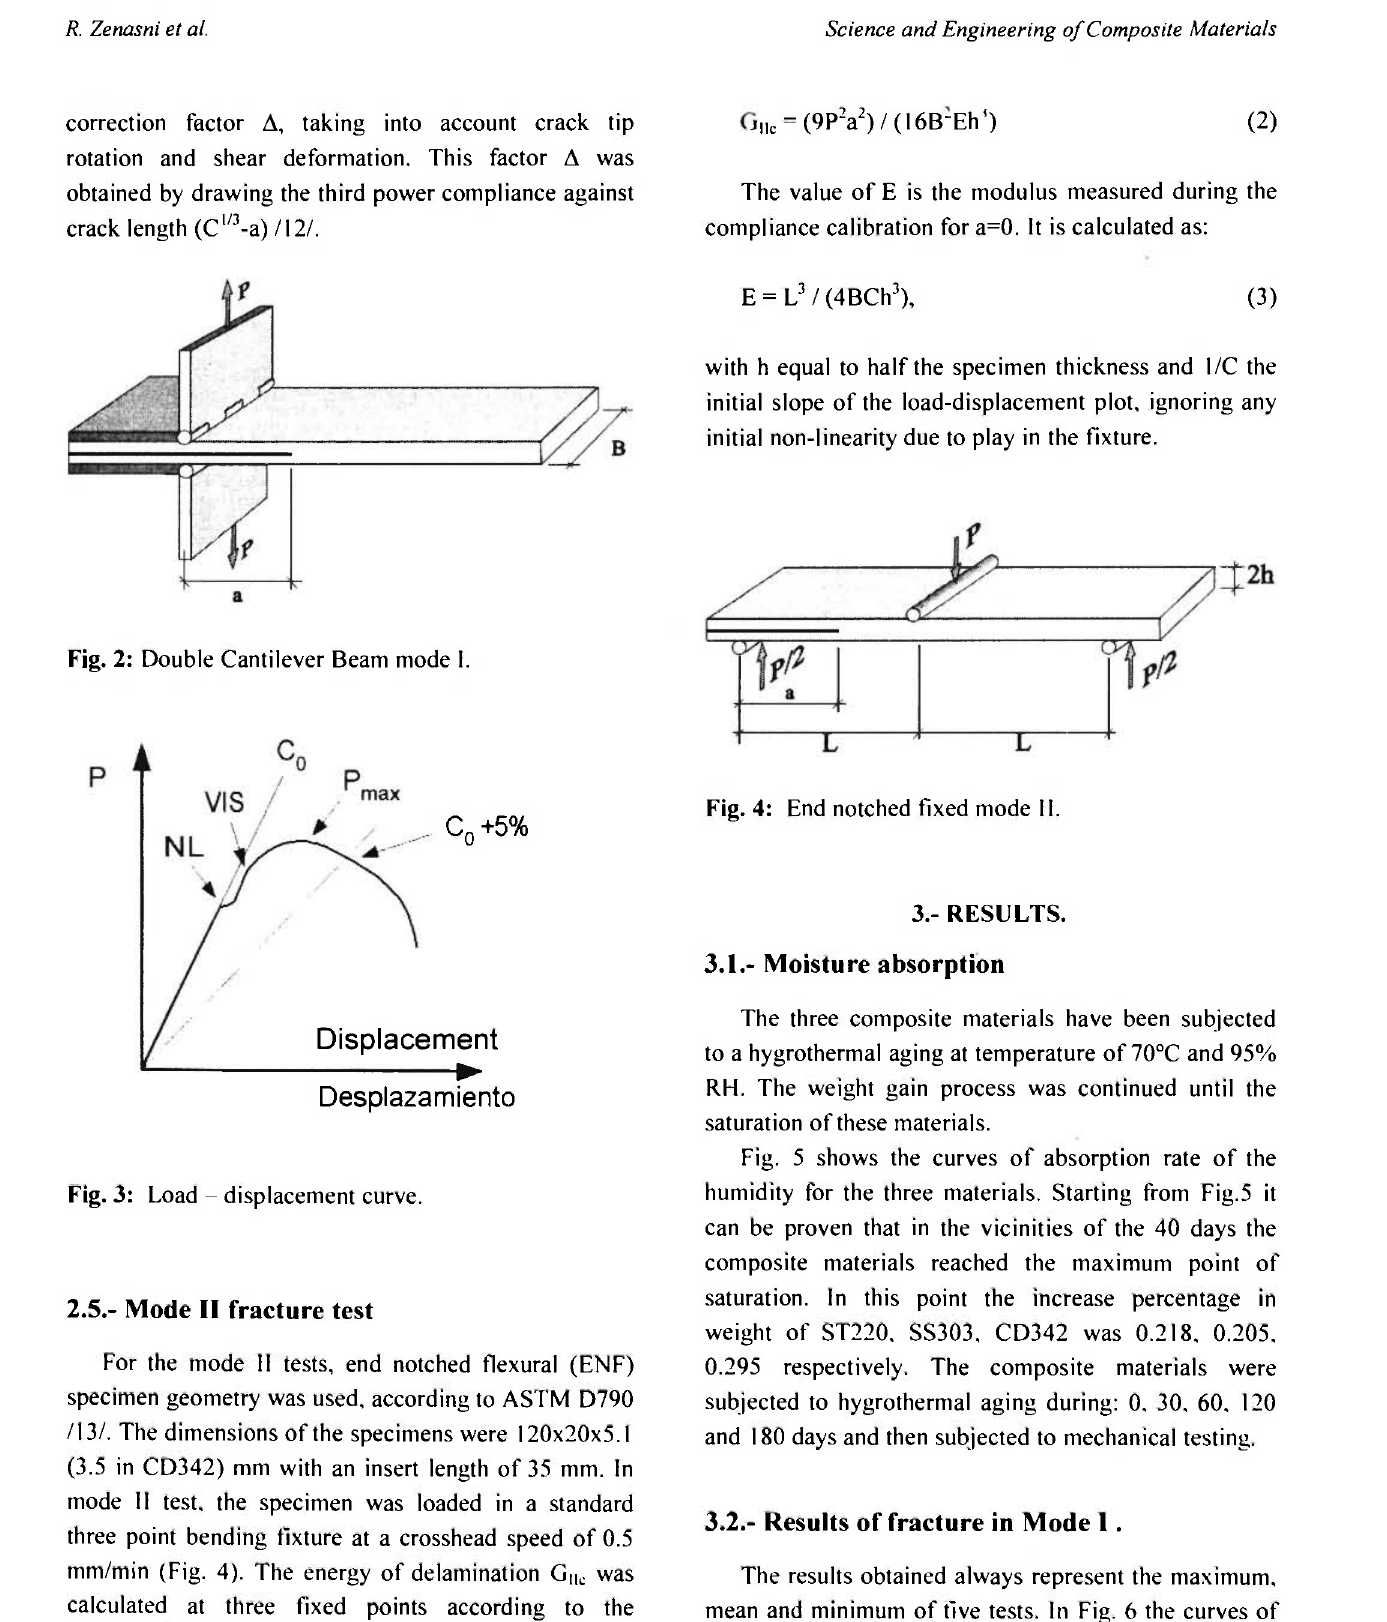
Fig. 3: Load - displacement curve.